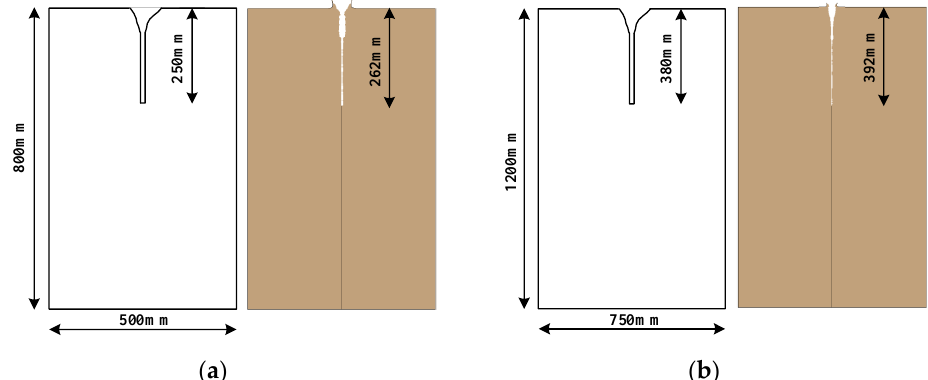
Figure 8. Comparisons of experimental and simulated penetration depths: ( a ) Scenario 1; ( b ) Sce- nario 2.